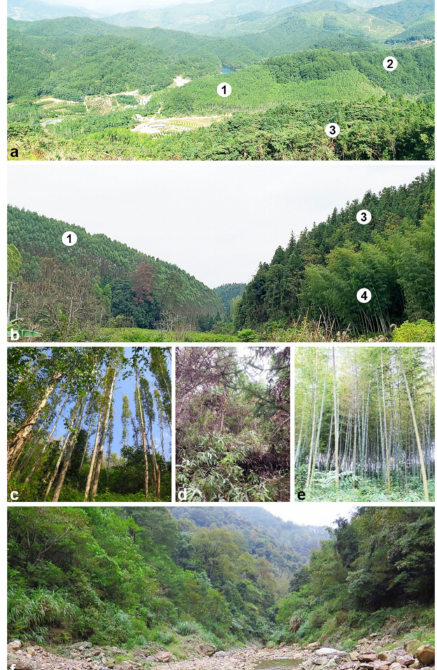
Figure 1. Different forest plantations and natural forests in southern China. ( a ). mixed species plantations in Zhangzhou Region, Fujian Province, 1: Eucalyptus sp., 2: Pinus massoniana , 3: Cun- ninghamia lanceolata ; ( b ). mixed species plantations in Jiangxi Province, 1: Eucalyptus sp., 3: Cunning- hamia lanceolata ; 4: Phyllostachys heterocycle ; ( c ). Eucalyptus sp. in Yongan Region, Fujian Province; ( d ). Cunninghamia lanceolata in JiangXi Province; ( e ). Phyllostachys heterocycle in Nanping Region, Fujian Province; ( f ). natural forests in Nanping Region, Fujian Province. Soil samples in this study were collected from Fujian